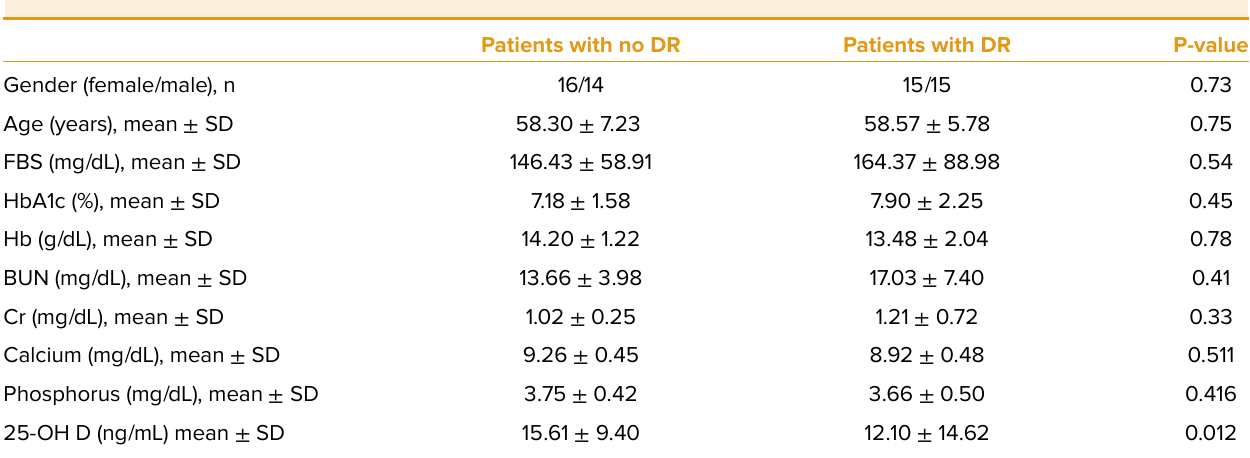
BUN, blood urea nitrogen; Cr, creatinine; DR, diabetic retinopathy; FBS, fasting blood sugar; HbA1c, hemoglobin A1c; Hb, hemoglobin; SD, standard